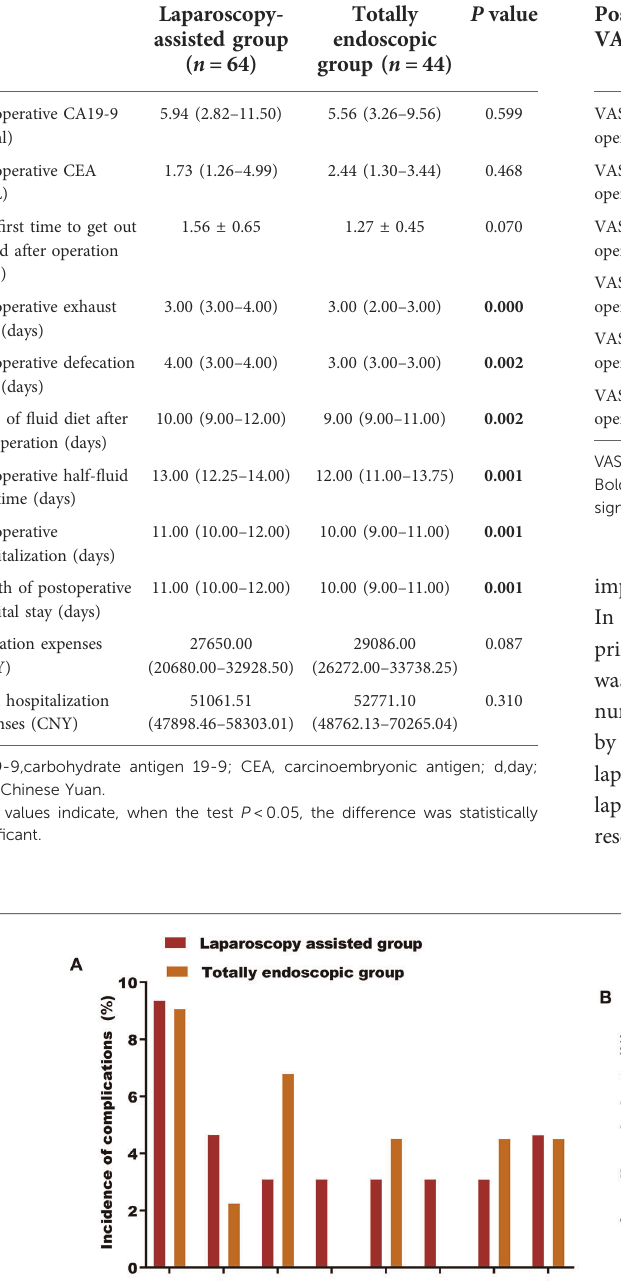
TABLE 3 postoperative recovery index. TABLE 4 postoperative recovery index.